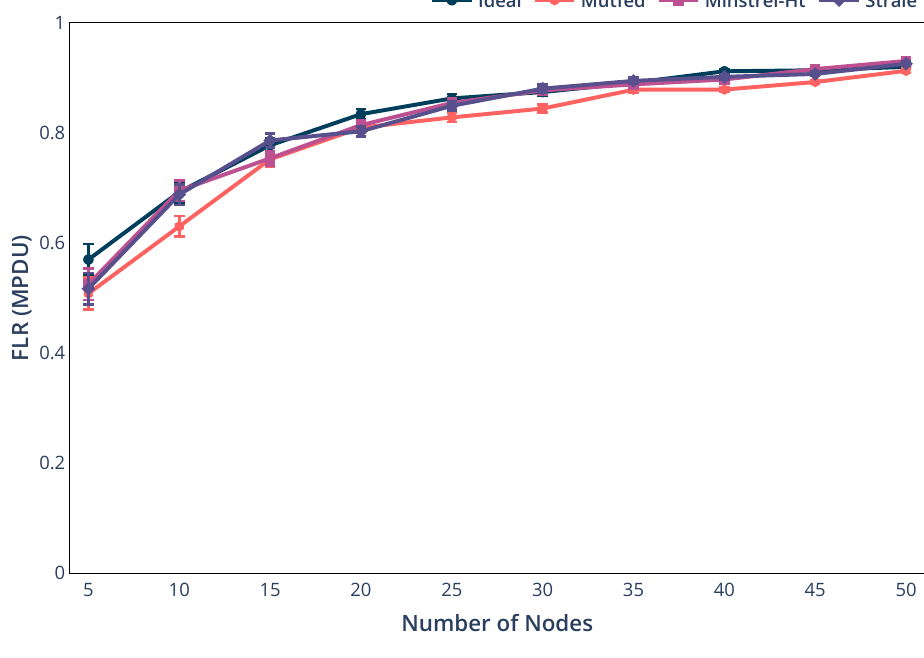
Figure 3. MAC Protocol Data Unit (MPDU) Frame Loss Ratio.